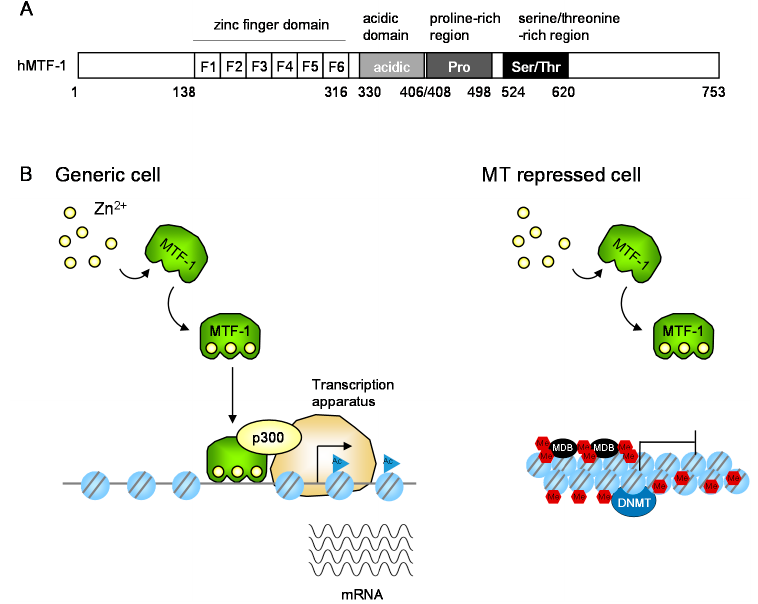
Figure 3. Expression regulation of MT gene expression. ( A ) Schematic representation of human metal response element-binding transcription factor-1 (MTF-1). The regions of the six-zinc fingers (F1–F6), acidic, proline-rich, and serine/threonine-rich domains are indicated by boxes and amino acid numbers; ( B ) Proposed molecular mechanisms in MT transcription in response to increases of intracellular free zinc. In generic cells, MTF-1 recruits the histone acetyltransferase p300 and increases MT transcription. In MT-repressed cells such as lymphosarcoma cells, and cancer cells, the promoter is highly methylated. DNA methyltransferase (DNMT) and methyl CpG binding proteins (MBD) are involved in the suppression. The epigenetic mechanism is described in Section 4.2. Ac, acetyl group; Me, methyl group; blue circle with two lines,